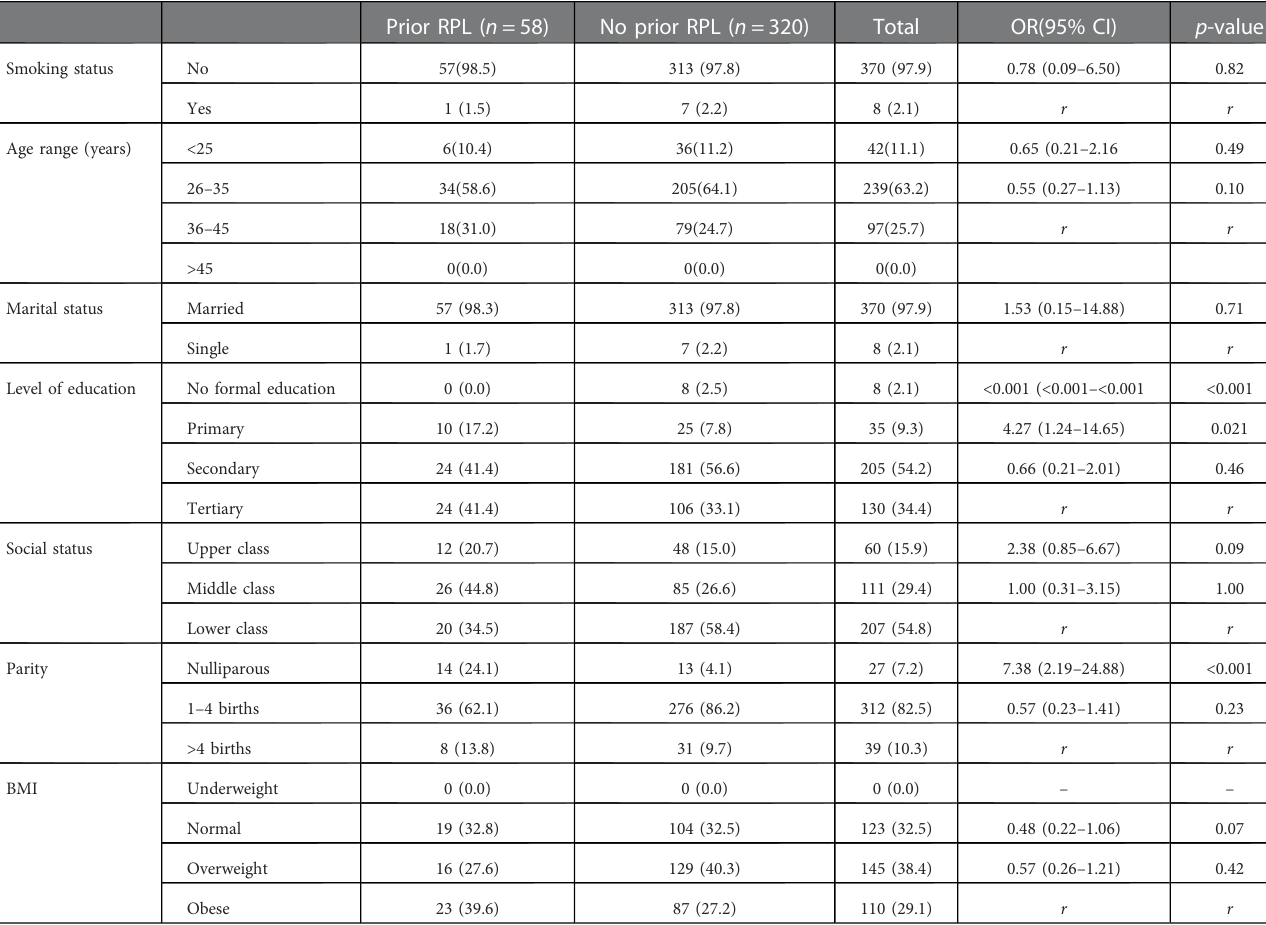
TABLE 1 Bi-variable logistic regression of sociodemographic distribution of participants across research